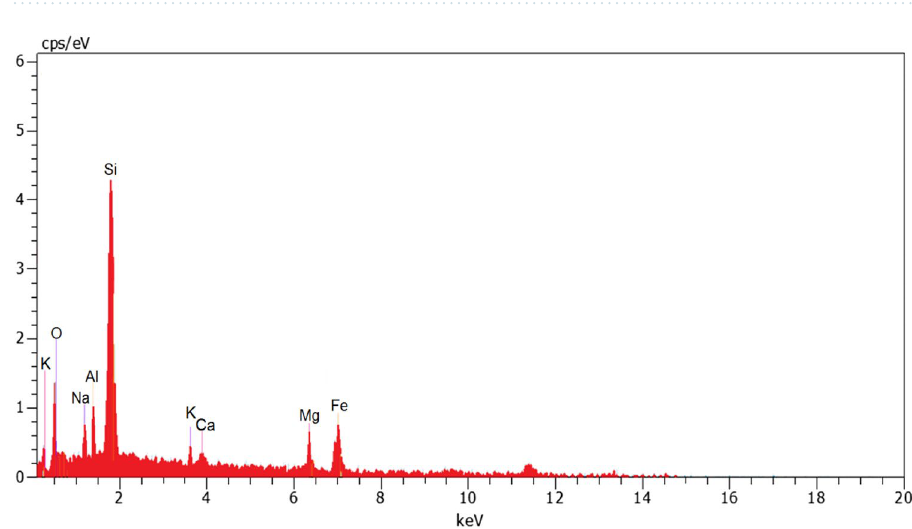
Figure 2. EDX analysis of